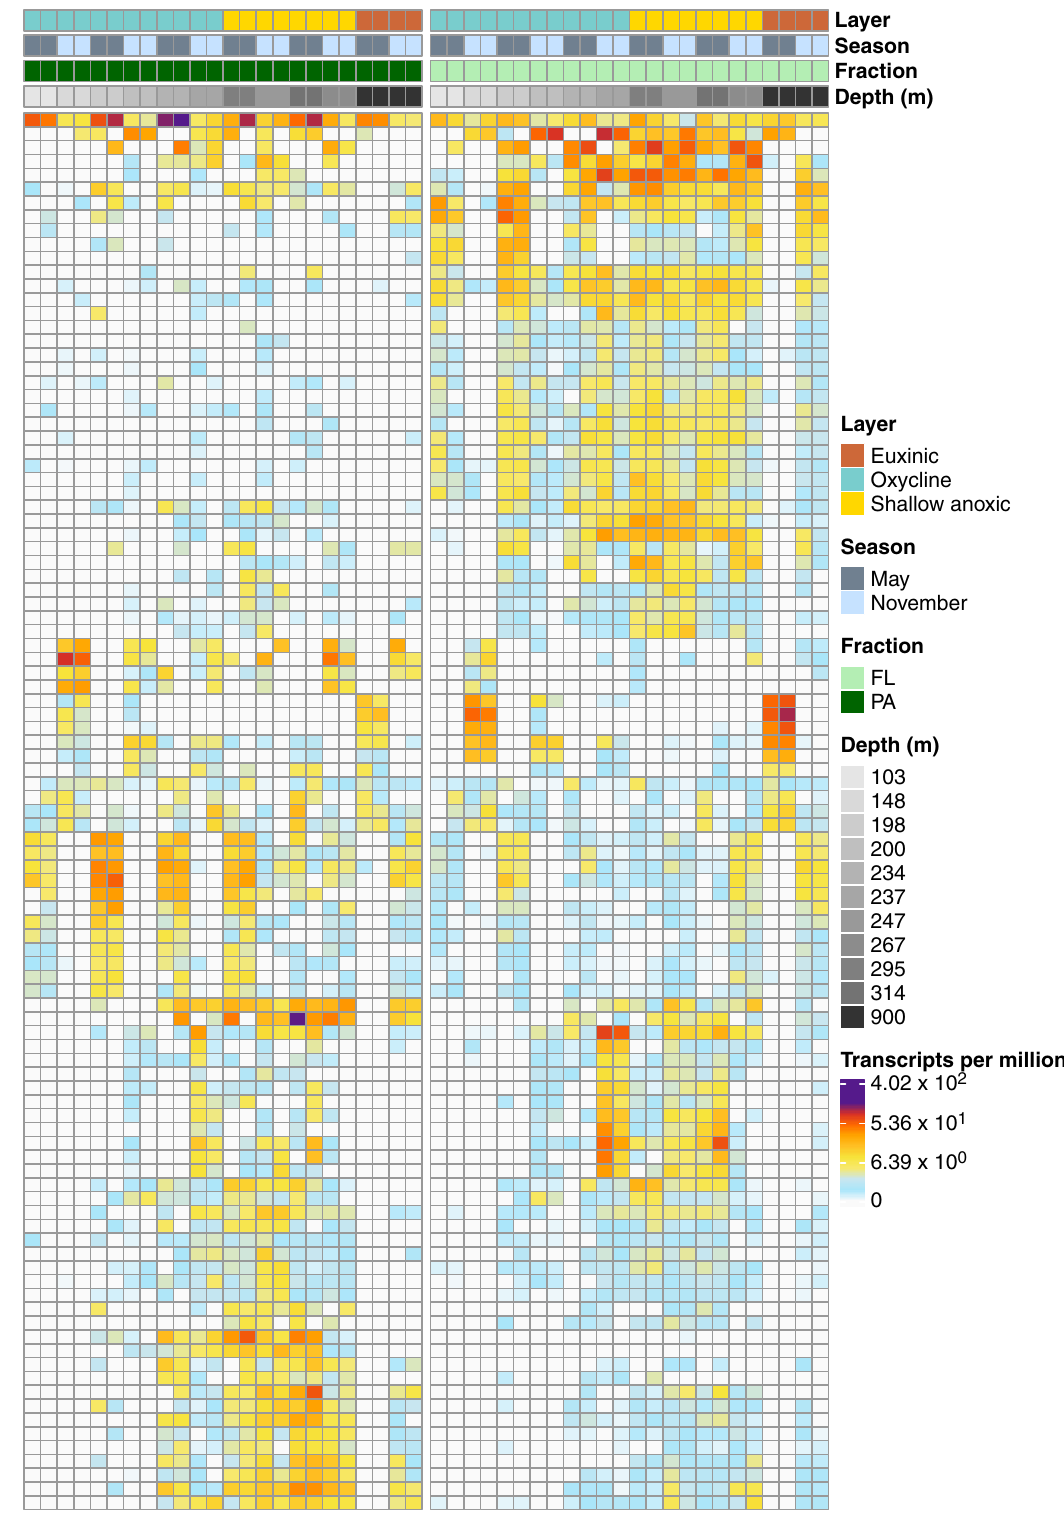
Fig. 2 | Expression of secondary metabolite biosynthetic transcripts from individual MAGs in metatranscriptomic samples. Each row represents a bio- synthetic transcript, each column represents a sample from the PA fraction (left)